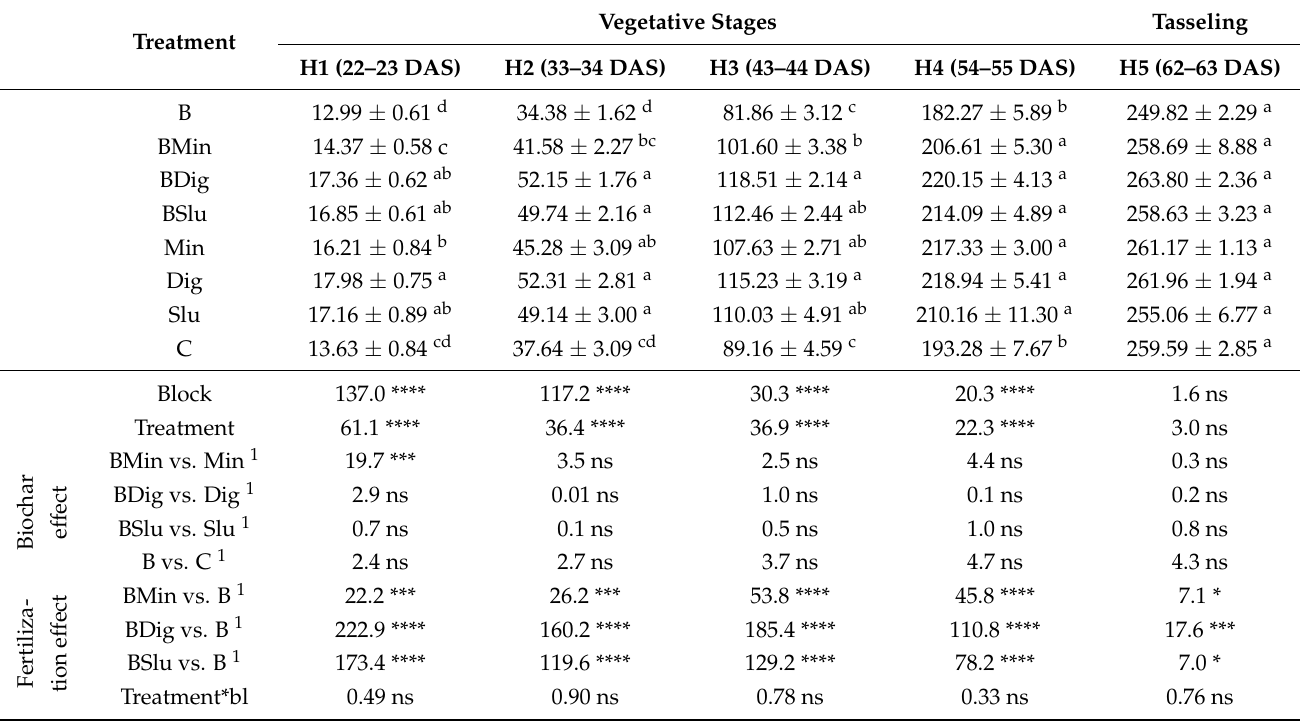
Table 4. Silage maize growth dynamics in 2019 in terms of plant height (cm) at the uppermost leaf collar stage at the day after sowing (DAS) indicated; mean values and SE; analysis of variance (ANOVA) comparisons of fertilization effects in presence and absence of biochar.